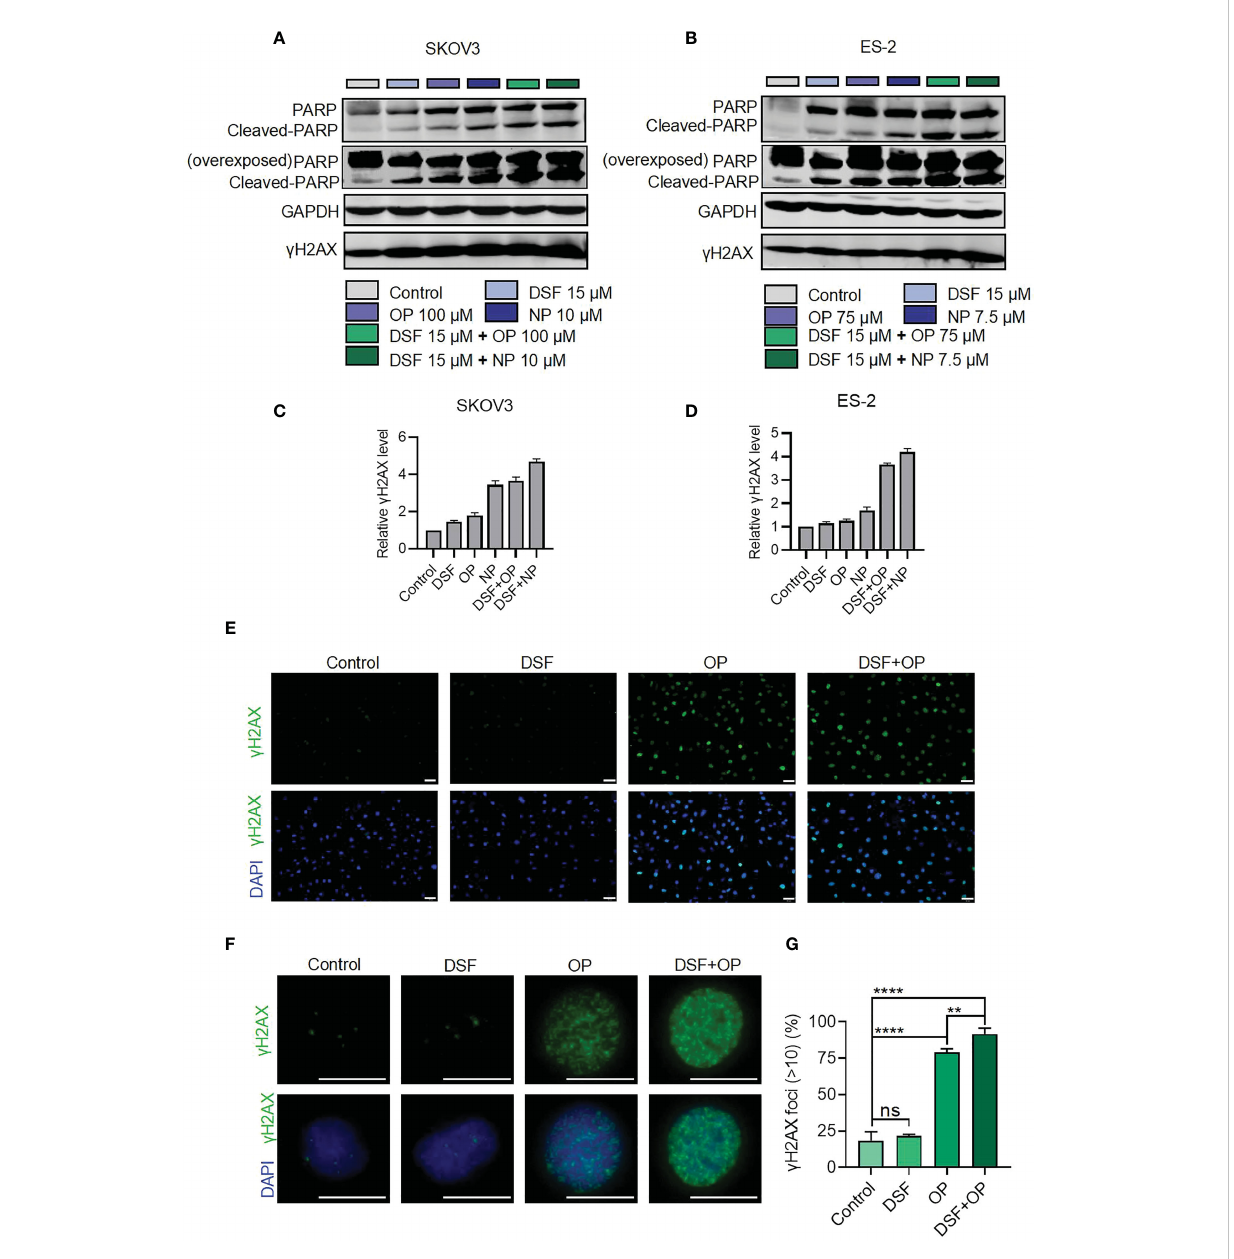
FIGURE 4 Protein expression of PARP and g H2AX in the presence of Disul fi ram and Olaparib and Niraparib. Expression of PARP and g H2AX detected using western blot analysis after treatment with disul fi ram and PARP inhibitors alone or in combination in SKOV3 (A) and ES-2 cells (B) . Densitometry analysis of g H2AX levels normalized to GAPDH in SKOV3 (C) and ES-2 (D) . Immuno fl uorescence staining for H2AX in cells treated with Disul fi ram (3.75 m M) and Olaparib (25 m M) (E and F). Scale bars are 50 m m (E) , and 20 m m (F) . Quanti fi cation of g H2AX expression (G) . The g H2AX foci >10 in all cells in each case were calculated. The experiment was repeated three times. Error bars represent mean ± SD. Unpaired t-test, ns indicates no signi fi cant difference, ** P <0.01, **** P